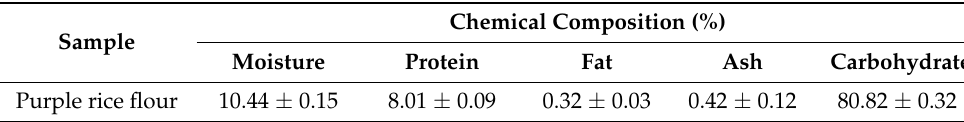
Table 1. Chemical compositions of purple rice flour.